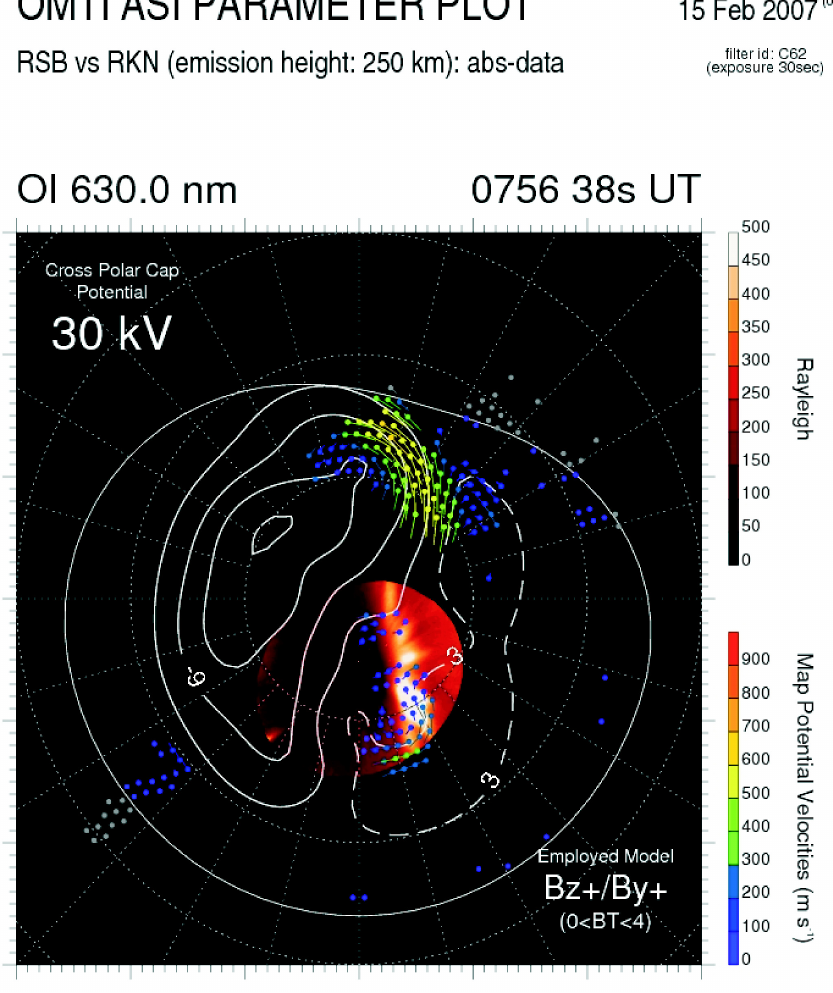
Fig. 8. Global map of plasma convection inferred from SuperDARM measurements at 07:56UT and location of the optical form. Midnight is at the